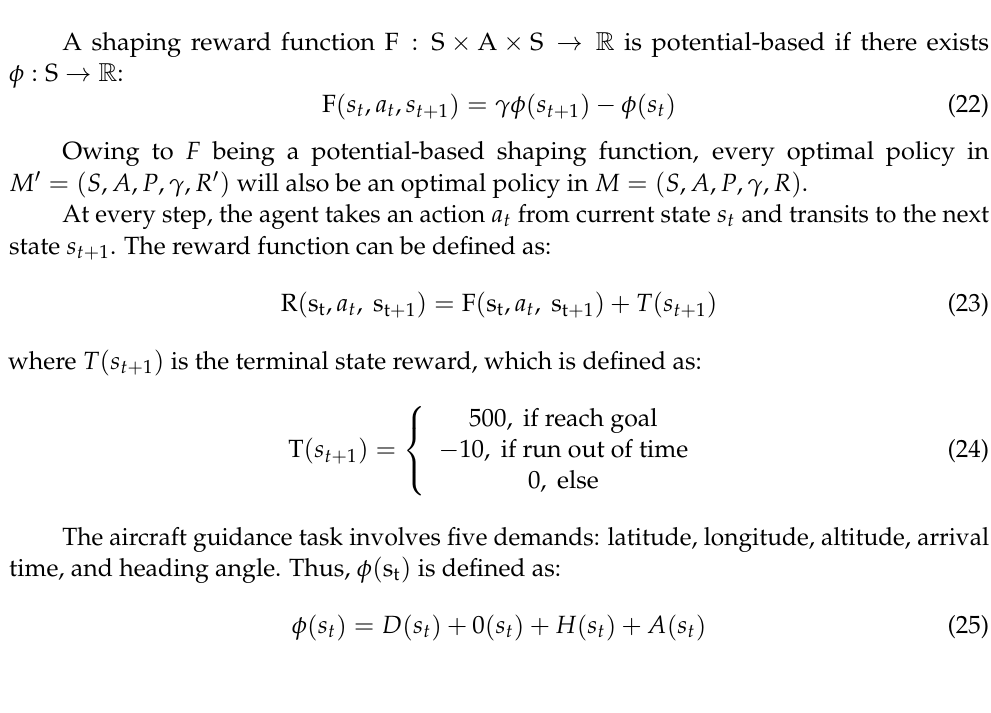
Figure 8. Potential value associated with each